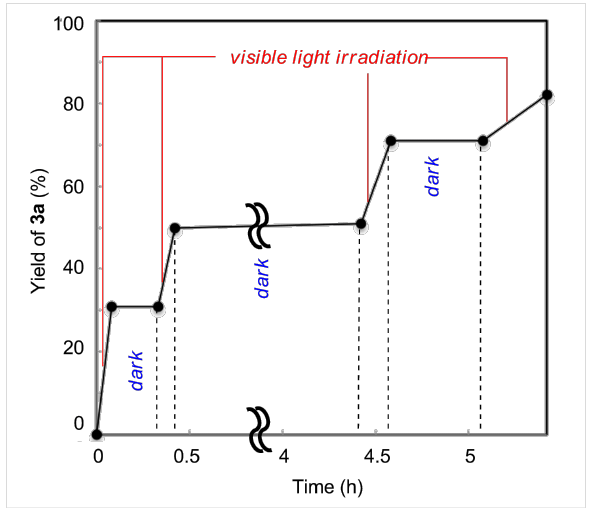
Figure 1: Time profile of the photocatalytic trifluoromethylation of 2a with 1a with intermittent irradiation by blue